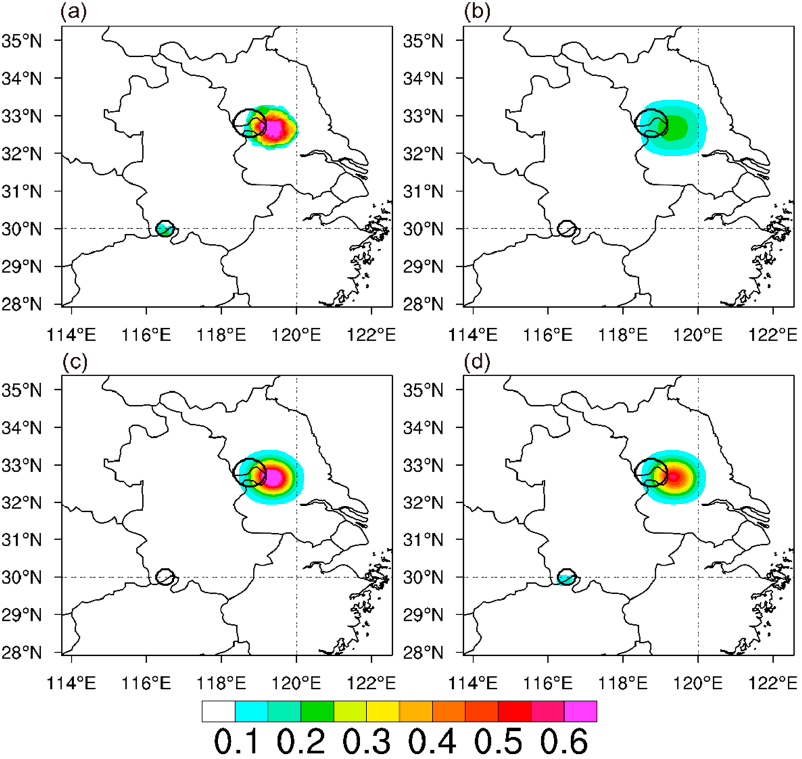
Figure 7. Probabilistic forecasts for an idealized experiment for ( a ) GP, ( b ) NEP, ( c ) EAS_NEP, ( d ) OBJ_NEP. The black contours represent observations.